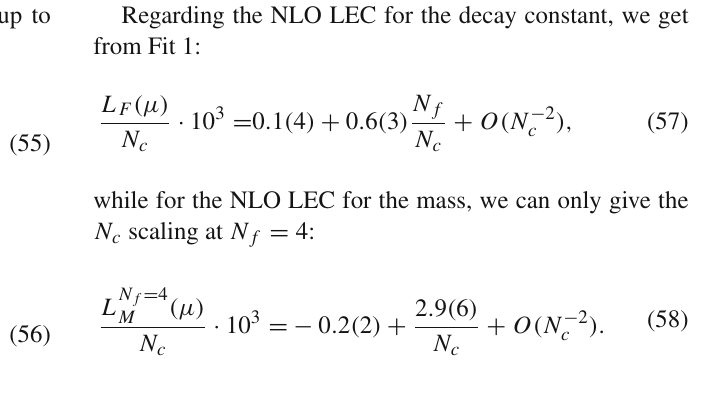
N f = 2 and N f = 3, where the Z P factor drops (up